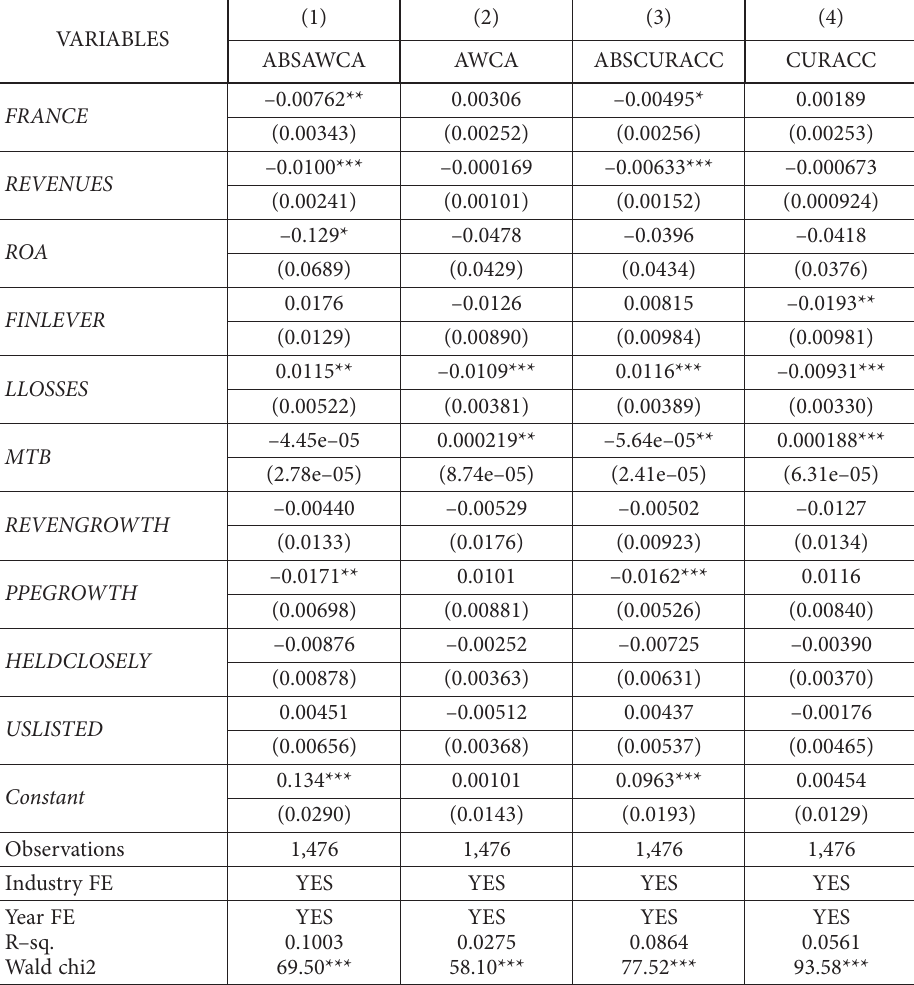
Table 3. The relationship between joint audits and discretionary accruals. Results of the estimations conducted with the non-Anglo-Saxon subsample VARIABLES